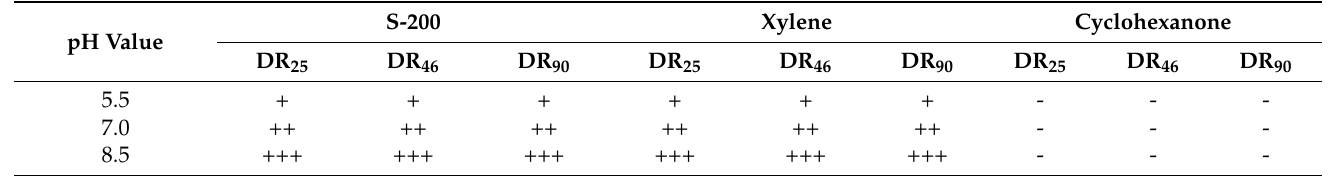
Table 3. Emulsifying activity of DR 25 , DR 46 and DR 90 at various pH a